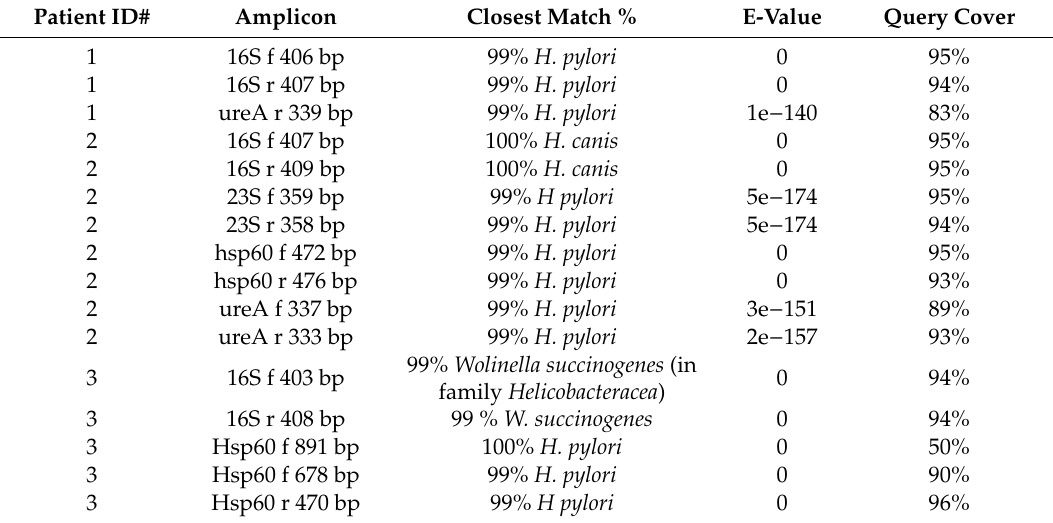
Table 6. BLAST analyses of Hp